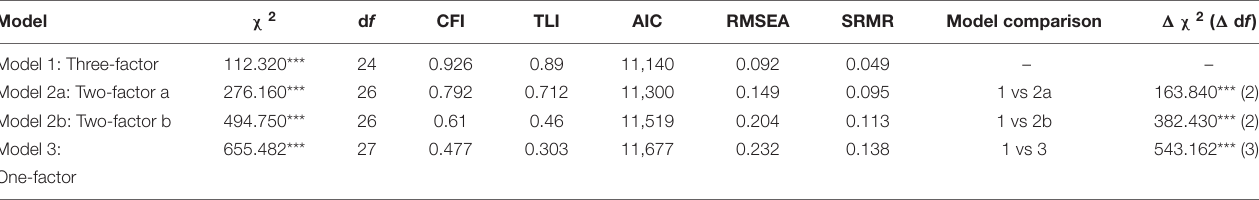
TABLE 3 | Goodness of fit indices and Chi-Square difference tests of the sub-factors of the ABW-B, Sample 2. Model χ 2 d f CFI TLI AIC RMSEA SRMR Model comparison